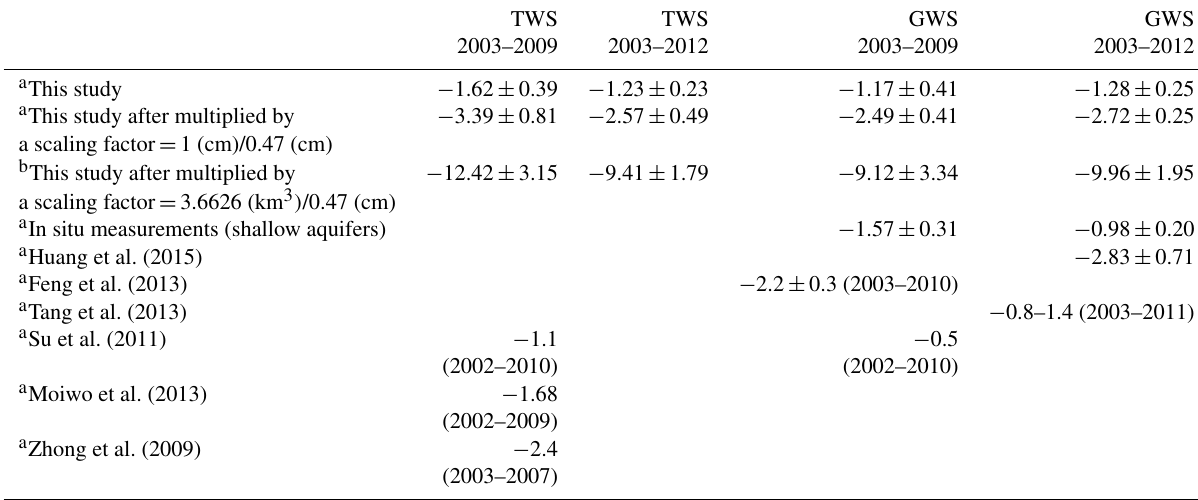
Table 2. Trends of GRACE-derived TWS and GWS (GRACE minus GLDAS/Noah) in situ measurements (shallow aquifers) and compared with the previous studies during 2003–2012.